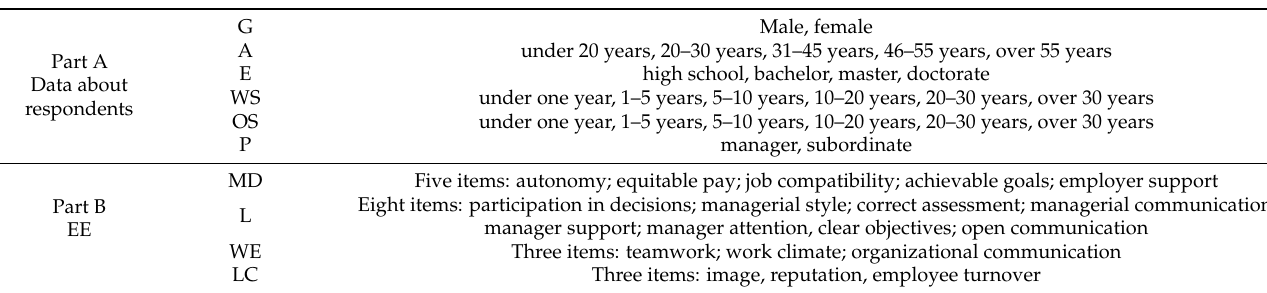
Table A1. Questionnaire